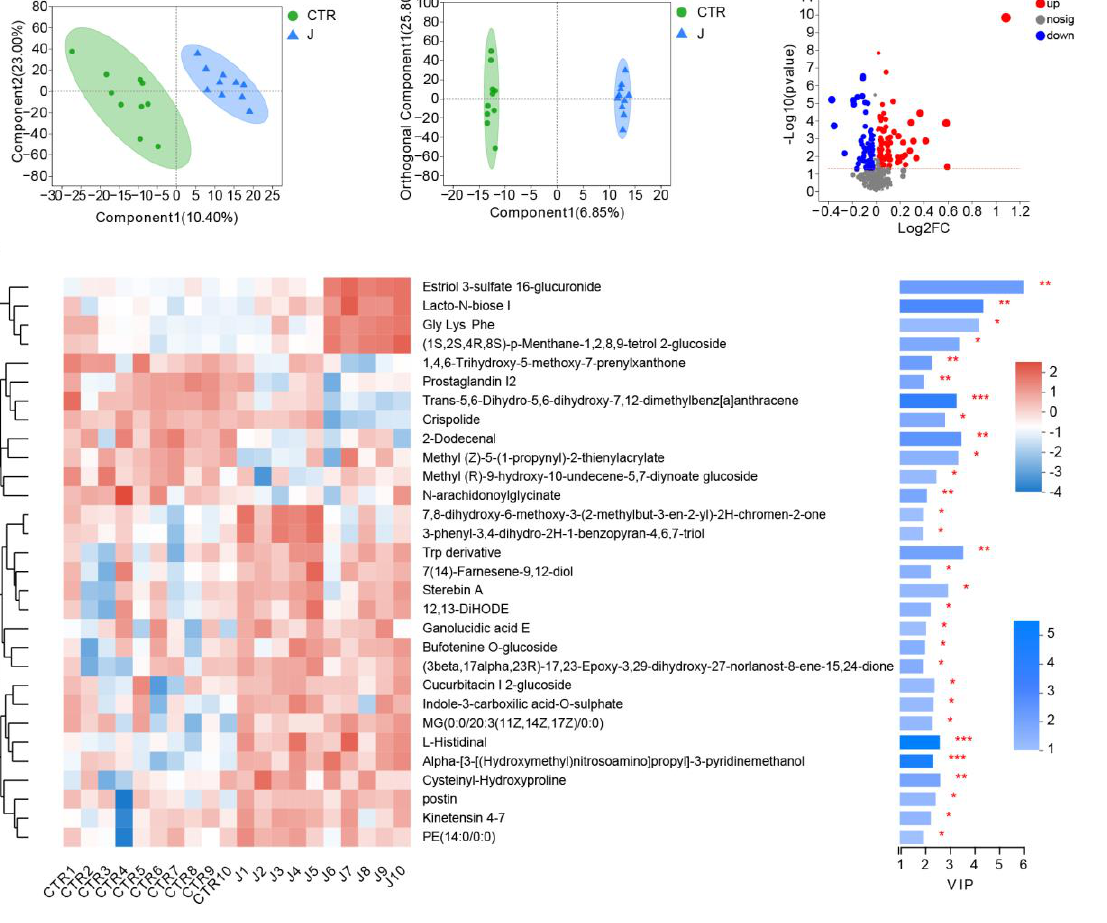
Figure 5. The effect of jujube on the metabolite structure and composition of gut microbiota in mice. ( A ) Partial least squares discriminant analysis based on metabolism variations between the jujube and control groups. ( B ) Orthogonal partial least squares discriminant analysis based on metabolism variations between the jujube and control groups. ( C ) Volcano plot of differences in metabolites between the jujube and control groups ( p < 0.05); variable importance in the projection of orthogonal partial least squares discriminant analysis (VIP_OPLS-DA > 1). ( D ) Heatmap of important changes in gut microbiota metabolites in each mouse. * p < 0.05, ** p < 0.01, *** p < 0.001.